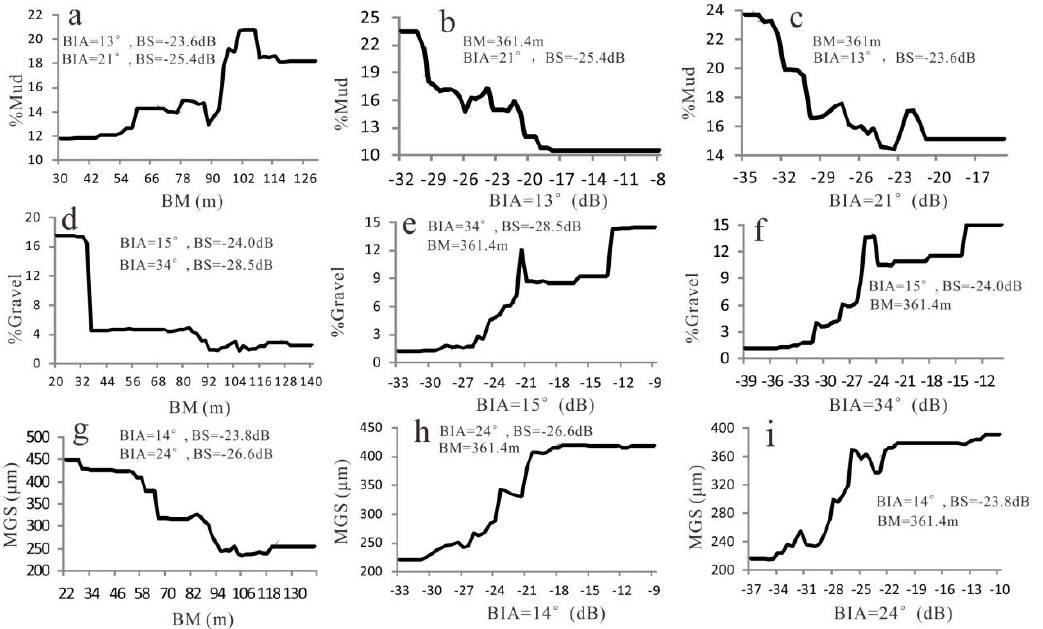
Figure 3. The predictive relationship curves between the characteristic variables and sediment properties. ( a ), %mud and BM; ( b ), %mud and BIA = 13°; ( c ), %mud and BIA = 21°; ( d ), %gravel and BM; ( e ), %gravel and BIA = 15°; ( f ), %gravel and BIA = 34°; ( g ), MGS and BM; ( h ), MGS and BIA = 14°; ( i ), MGS and BIA = 24°. BM indicates bathymetry, BIA indicates incidence angle of backscatter, and BS indicates backscatter intensity.